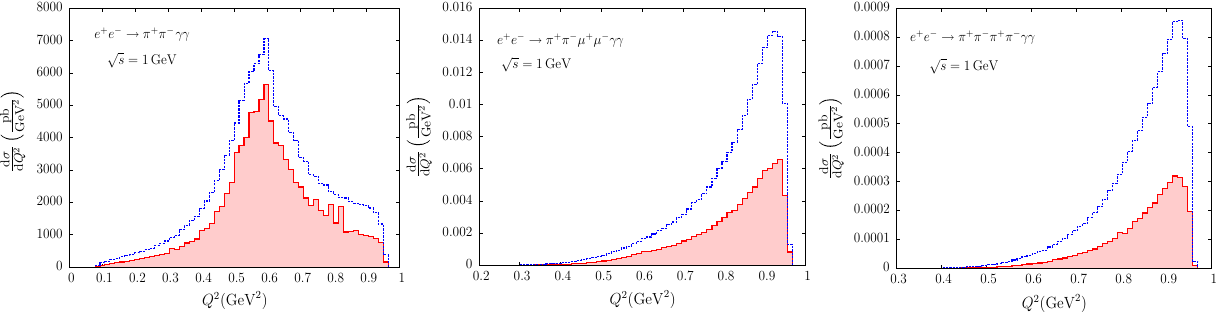
√ s = 1 GeV as functions of invariant mass of the π + π − -, π + π − μ + μ − and